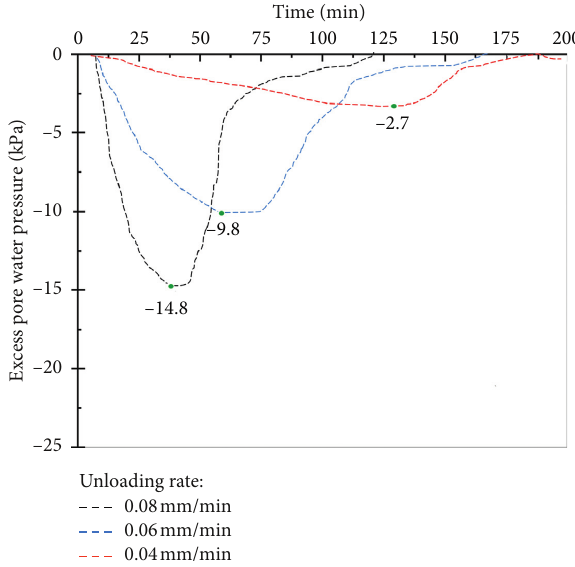
Figure 9: Curves of excess pore water pressure values with time under different unloading rates at a confining pressure of